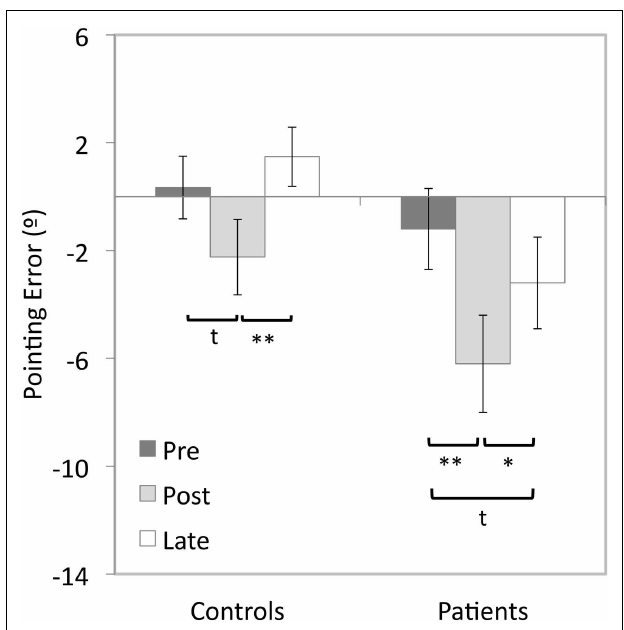
FIGURE 3 |Vertical errors (˚) for open-loop pointing movements made after 5min of adaptation to upward-shifting prisms by patients with Parkinson’s disease and control participants for the pre- post- and late-tests in Experiment 2. Positive values indicate upward errors, negative values indicate downward errors. * p < 0.05, ** p s < 0.01, t = trend, error bars represent ±